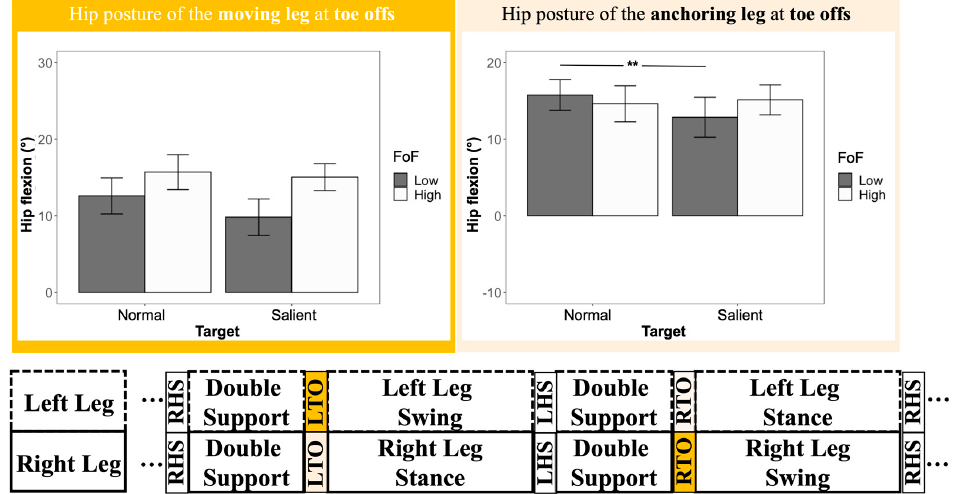
Figure 7. Hip flexion of the moving leg (dark yellow) and the anchoring leg (light yellow) at toe offs. The double-asterisk symbol (**) was used to indicate a significant difference with an alpha level of 0.01.